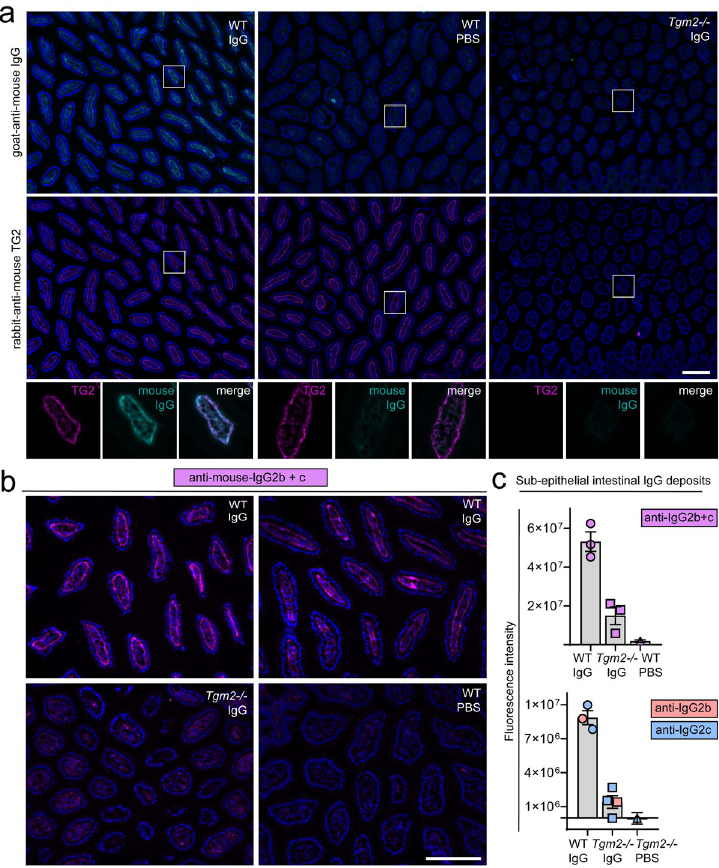
Fig 3. Injected anti-TG2 antibodies reach the intestinal tissue. (a) Immunofluorescence staining of frozen sections of small intestine obtained on day 20 show deposition of mouse IgG (cyan) in the basement membrane of IgG injected WT mice that co-localizes with ECM staining for endogenous TG2 (magenta). No IgG deposits were detected in PBS injected WT mice and no clear ECM deposits were observed in IgG-injected Tgm2-/- mice. Nuclei counterstained with DAPI are shown in blue. (b) Distribution of IgG2b and IgG2c in the small intestine of WT mice injected with IgG (top panels). Weak antibody signal is detected also in the intestine of Tgm2 -/ - mice while no signal is seen in PBS-injected mice, which indicates that antibody presence in tissue does not per se depend on presence of cognate antigen. (c) Quantification of subepithelial fluoresence signal intensity from staining for IgG2b and IgG2c together (top) or separately (bottom). Each dot represents mean fluorescence intensity calculated from one image as described in materials and methods. Bar graphs show the group mean fluorescence intensity with standard error of mean. Scale bars represent 100 μ